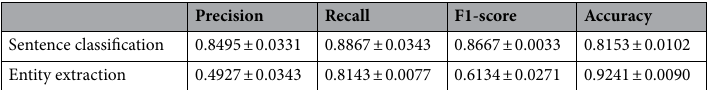
Table 1. Performance evaluation of the dual-task BERTweet